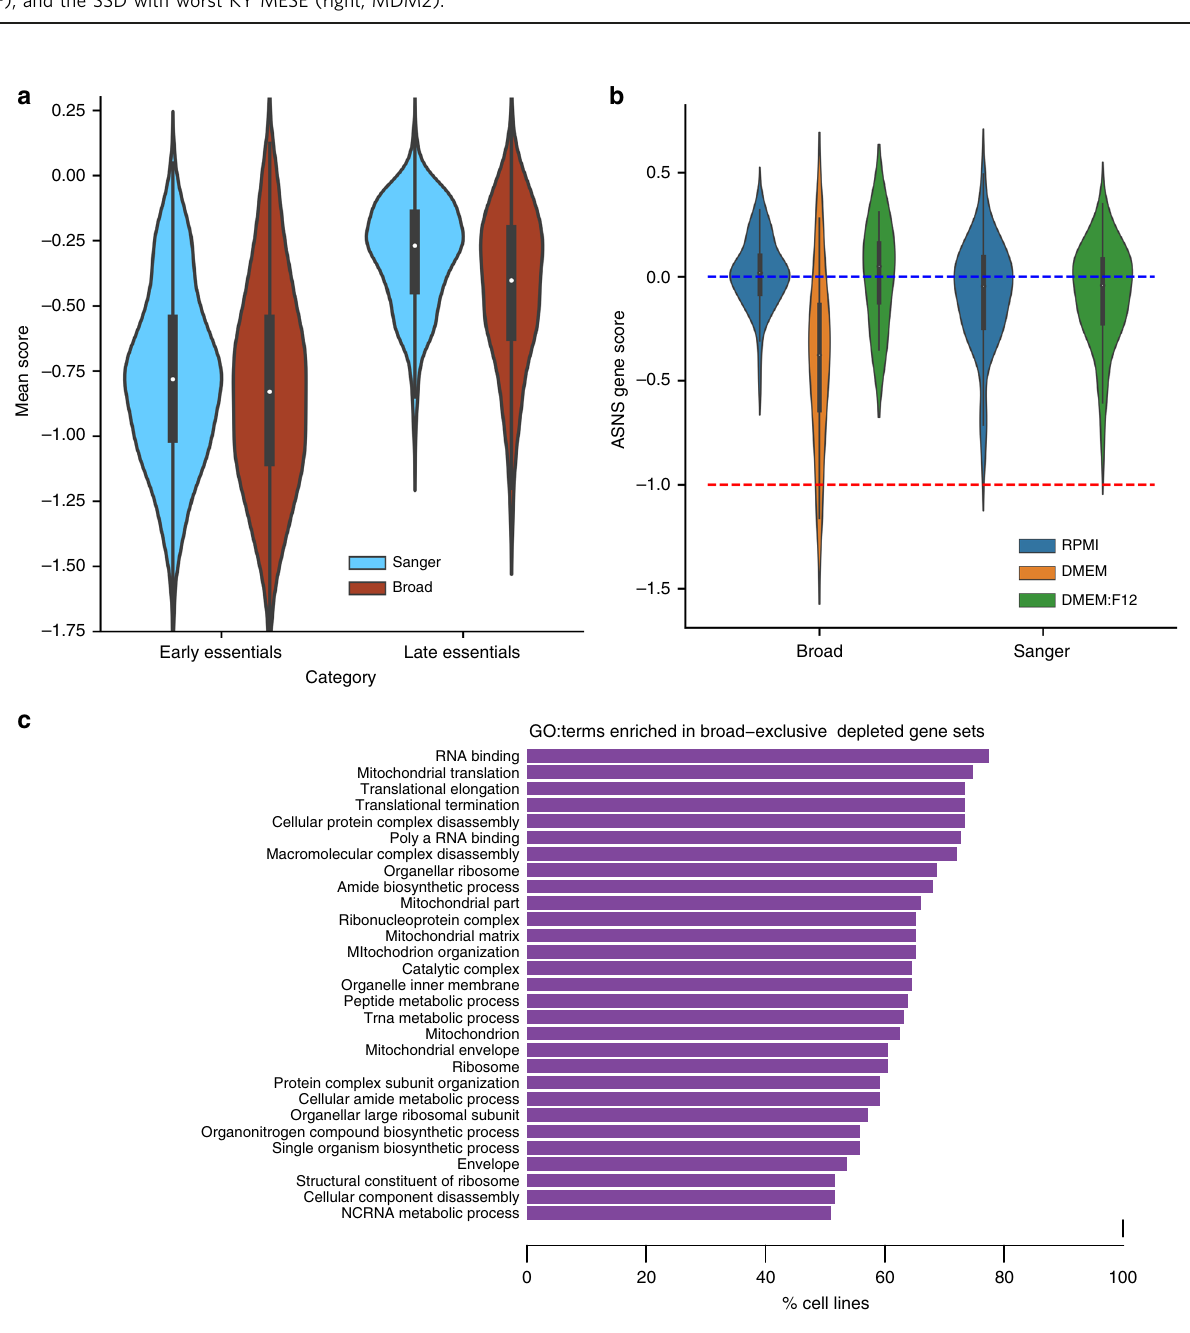
Fig. 4 In fl uence of reagent library on gene score. a Distributions of sgRNA depletion score correlations for sgRNAs targeting genes with varying NormLRT scores within each data set (left) and between them (right). Each gene is binned according to the mean of its NormLRT score across the two data sets. The x -axis de fi nes the color gradient. The y -axis reports the average of all correlations between pairs of sgRNAs that belong to the same data set and target that gene. Boxes cover the interquartile range with the median indicated by a horizontal line. Whiskers extend up to 1.5 time the interquartile range with outliers shown as fl iers. b Relationship between sgRNA correlation within data sets and gene correlation between data sets. The linear trend is shown for SSD genes. c The mean depletion of guides targeting common dependencies across all replicates vs Azimuth estimates of guide ef fi cacy. The x -axis de fi nes the color gradient. d Comparison of Broad and Sanger unprocessed gene scores for genes matching SSD with highest minimum median estimated sgRNA ef fi cacy (MESE) across both libraries (left, TFA2C), common dependency in either data set and greatest difference between KY and Avana MESE (center, EIF3F), and the SSD with worst KY MESE (right, MDM2).